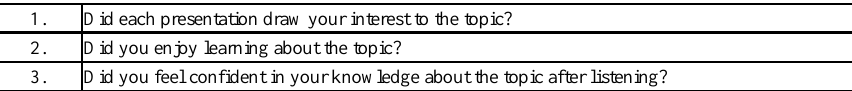
Table 5. Survey questions regarding students' attitudes on each topic of the